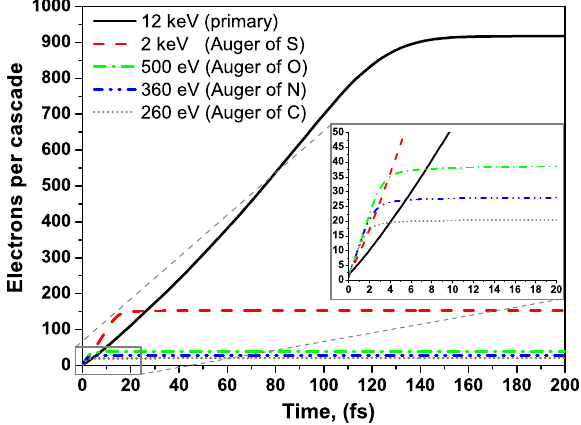
Figure 1. (Color online) Average number of secondary electrons created during impact ionizations by a single (photo- or Auger) electron within an infinitely extended, neutral protein as a function of time. Impact electrons of 12 keV energy (photoelectron), and energies of 2 keV, 500 eV, 360 eV and 260 eV, corresponding to respective K-shell Auger emission from S, O, N and C were